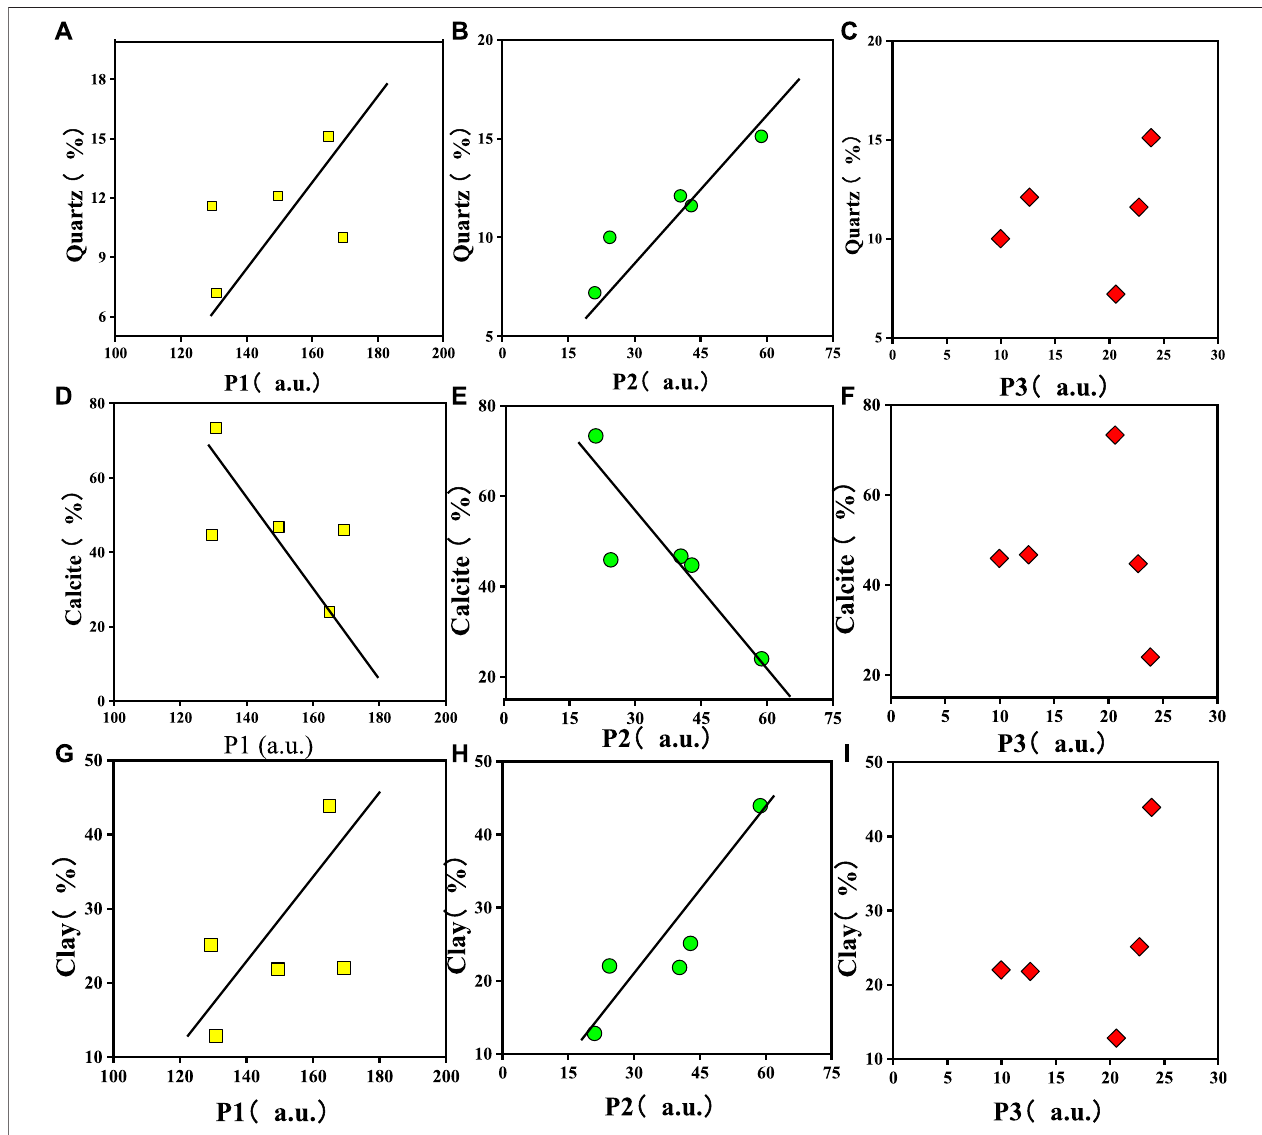
FIGURE 13 | Relationship between mineral compositions of quartz (A) – (C) , calcite (D) – (F) and clays (G) – (I) and areas of three peaks from NMR tests for dodecane-saturated samples.